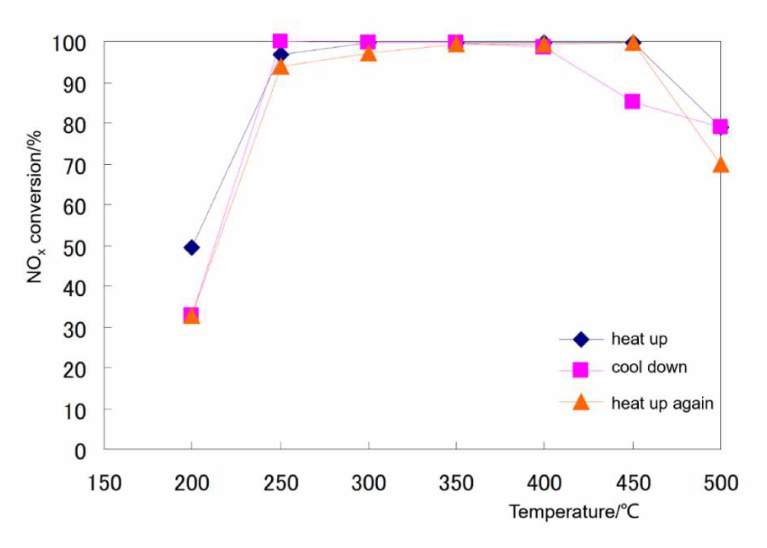
Figure 3. The catalytic activity of AgCl/Al 2 O 3 .